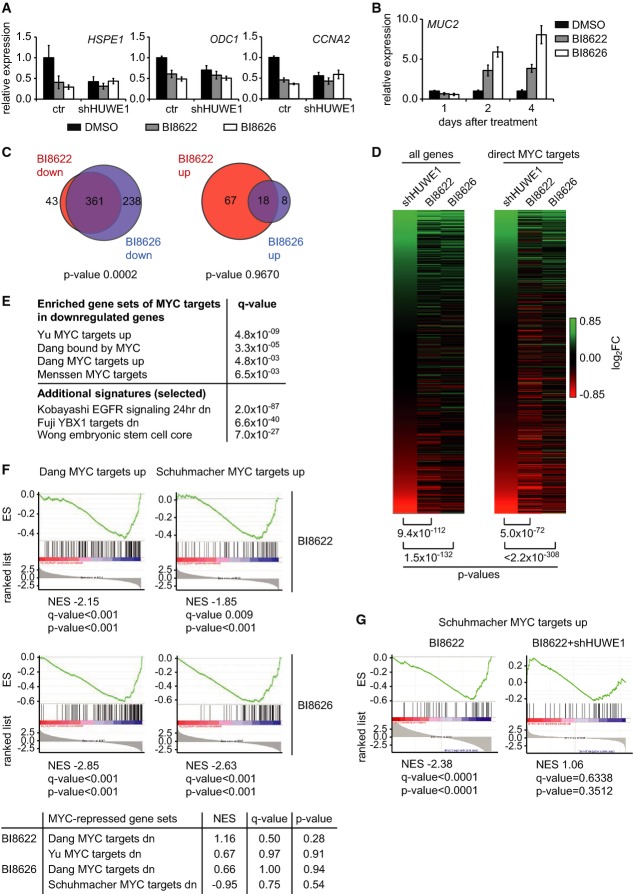
Effect of HUWE1 inhibition on expression of MYC target genesExpression of MYC target genes after HUWE1 inhibition in control and HUWE1-depleted Ls174T cells.
Control or HUWE1-depleted Ls174T cells were treated with HUWE1 inhibitors or DMSO as control for
24 h. Expression of different MYC-induced target genes was analyzed by RQ–PCR. Error
bars show SD of triplicate technical assays from one representative experiment
(n = 5).Time-dependent expression of the differentiation marker MUC2 upon HUWE1
inhibition. Ls174T cells were treated with HUWE1 inhibitors for the indicated times. Error bars show
SD of triplicate technical assays from one representative experiment
(n = 3).Gene set enrichment analysis (GSEA) of gene expression changes upon HUWE1 inhibition. Ls174T
cells were treated for 24 h with either HUWE1 inhibitor or DMSO as control. RNA was isolated
and subjected to a microarray and gene set enrichment analysis. The Venn diagrams display the number
of gene sets that overlap between BI8622 and BI8626 treated cells for down- and upregulated genes.
P-values were calculated using a test for hypergeometric distribution.Heat map comparing gene expression after HUWE1 depletion to treatment with HUWE1 inhibitors. The
left panel summarizes expression of all genes (n = 10,452)
ordered according to their expression after HUWE1 knockdown. The right panel shows all genes that
have a MYC binding site in the promoter (defined as −1 kb to +0.5 kb
relative to the TSS) (n = 5,664). MYC binding data were taken
from HeLa cells. P-values for correlation were calculated using a Spearman's
rank test.Examples of sets of genes that are downregulated upon HUWE1 inhibition. The panel shows examples
of sets of MYC-activated genes that are repressed upon incubation with either HUWE1 inhibitor.
Additional signatures are examples of genes related to MYC function.Effects of HUWE1 inhibition on expression of MYC target gene sets. The upper panels display
examples of MYC-activated gene sets and their response to inhibition of HUWE1. The table below shows
examples of MYC-repressed gene sets and their response to BI8622 and BI8626.The panel shows the response of a representative set of MYC-activated target genes to BI8622 in
control and HUWE1-depleted cells.